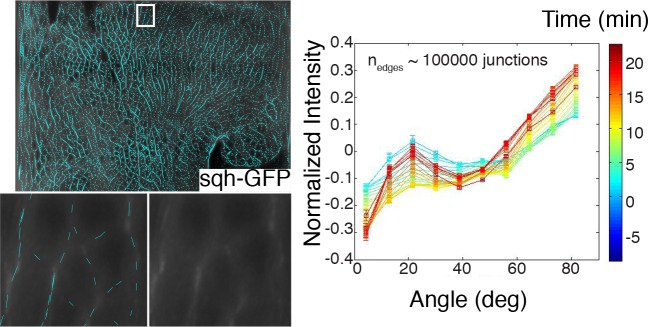
Example of edges identified with our anisotropy detection algorithm, and a magnification in a region of interest showing result in comparison with underlying raw data (left).Time course of normalized intensity (shifted to zero mean) versus edge orientation. Color codes for time as indicated in the colorer (right).